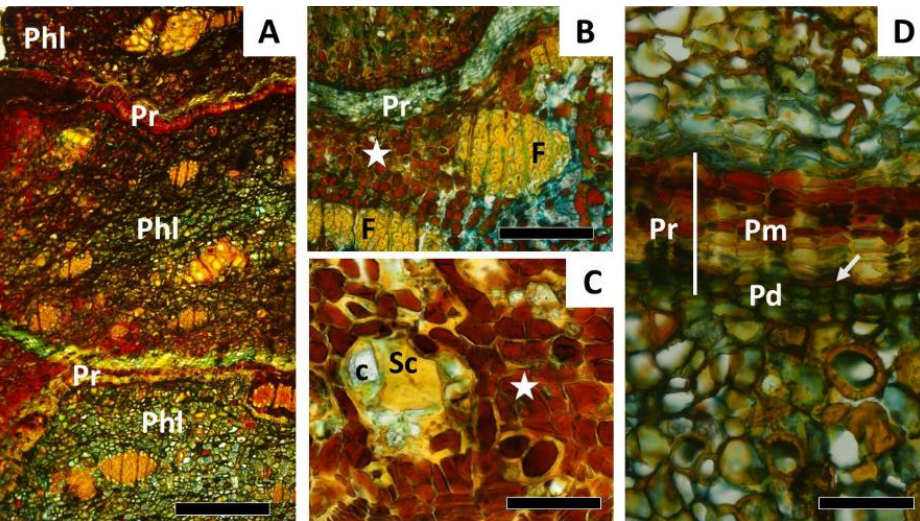
Figure 2. Transverse section of the bark of Quercus rotundifolia . ( A ) Rhytidome includes various periderms (Pr) and dead secondary phloem (Phl) between them; ( B ) portions of rhytidome—periderm (Pr), fibers (F), and parenchyma cells filled with extractives (asterisk); ( C ) sclereid with embedded crystal (c) and extractives in radial and axial parenchyma cells (asterisk); ( D ) a detailed view of the periderm with 7 cells of phellem (Pm) and 2–3 cells of phelloderm and the phellogen (arrow). Scale bar: A = 200 μm; B = 130 μm; C = 80 μm; D = 50 μm.